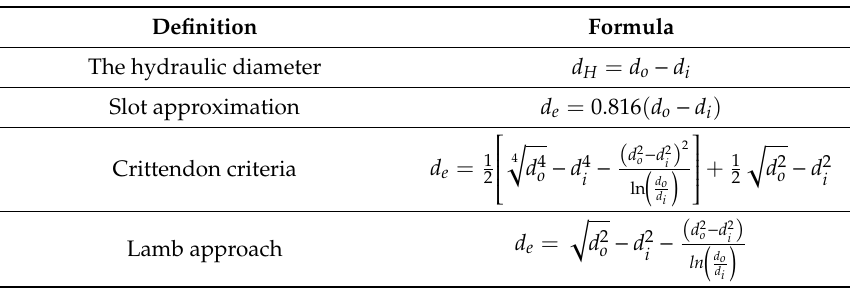
Table 1. Equivalent diameter definitions (adapted from [51]).